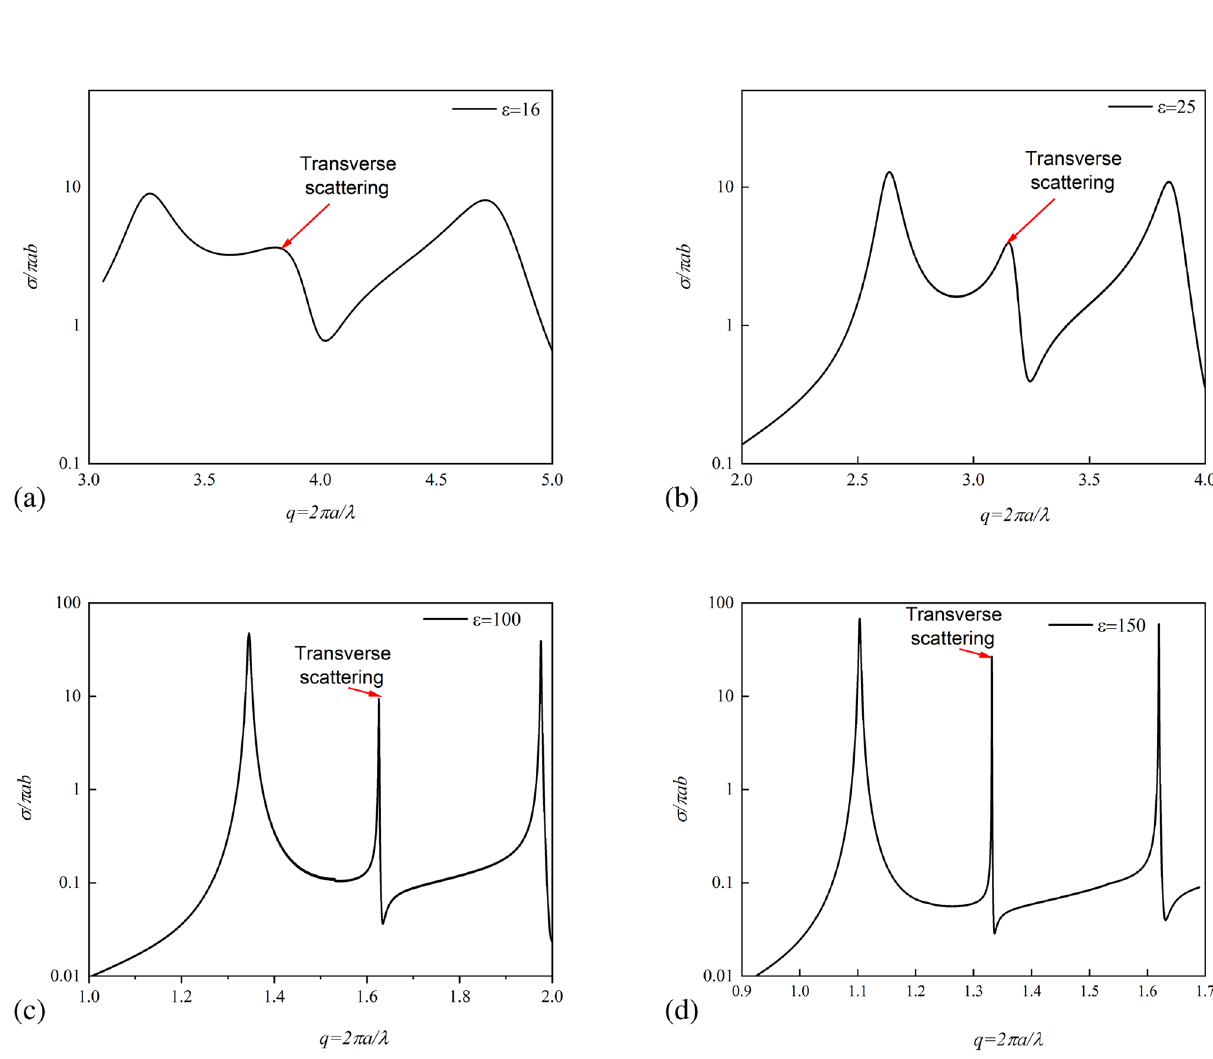
Figure 10. Normilized Scattering cross-section of spheroidal all-dielectric particle for different permittivities